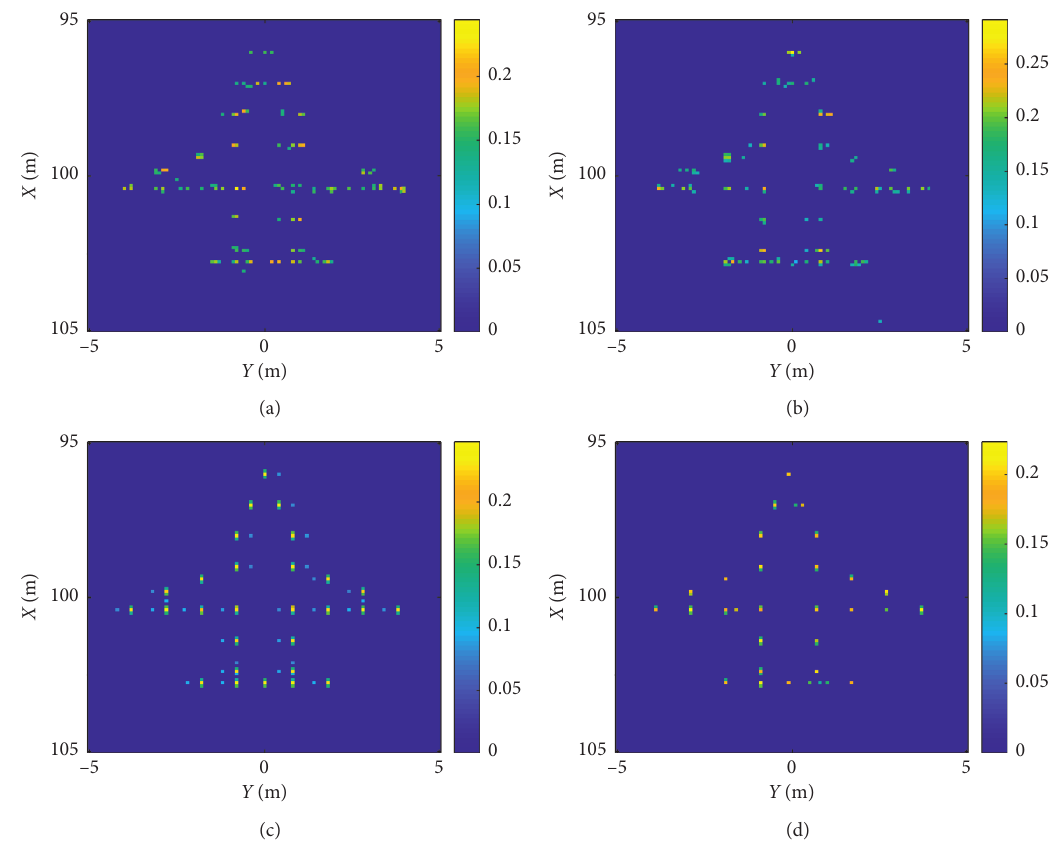
Figure 11: Comparison of OMP reconstruction results of four methods in –10 dB Gaussian white noise environment. (a) The result of point-by-point method. (b) The result of subaperture method. (c) The result of phase error correction method. (d) The result of the proposed method.